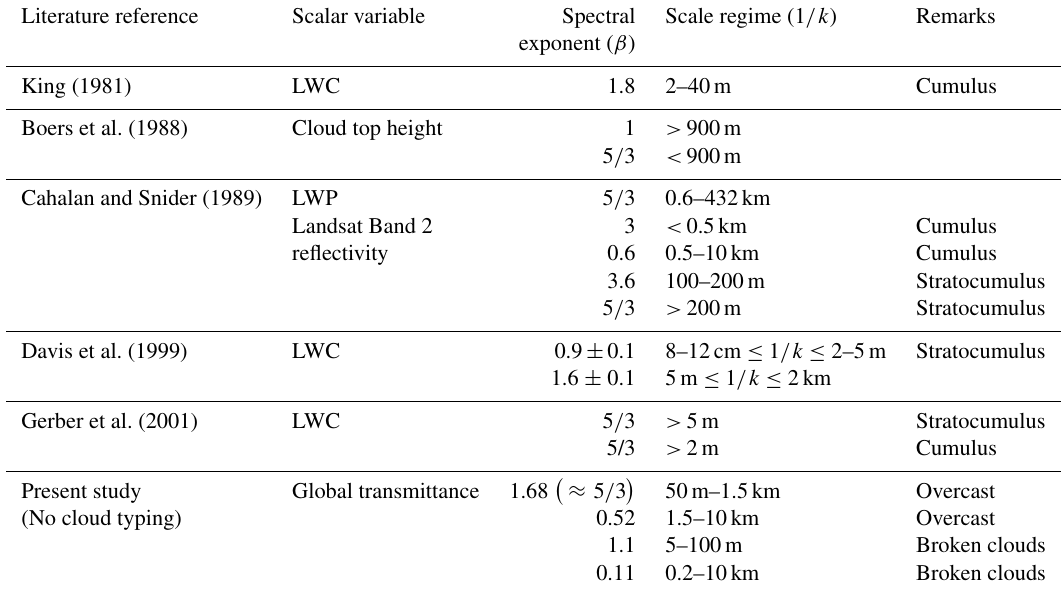
Table 3. Summary of the spectral power density of scalar variables with observed scale regimes and spectral exponents ( β ) as obtained by using Eq. (3) in different